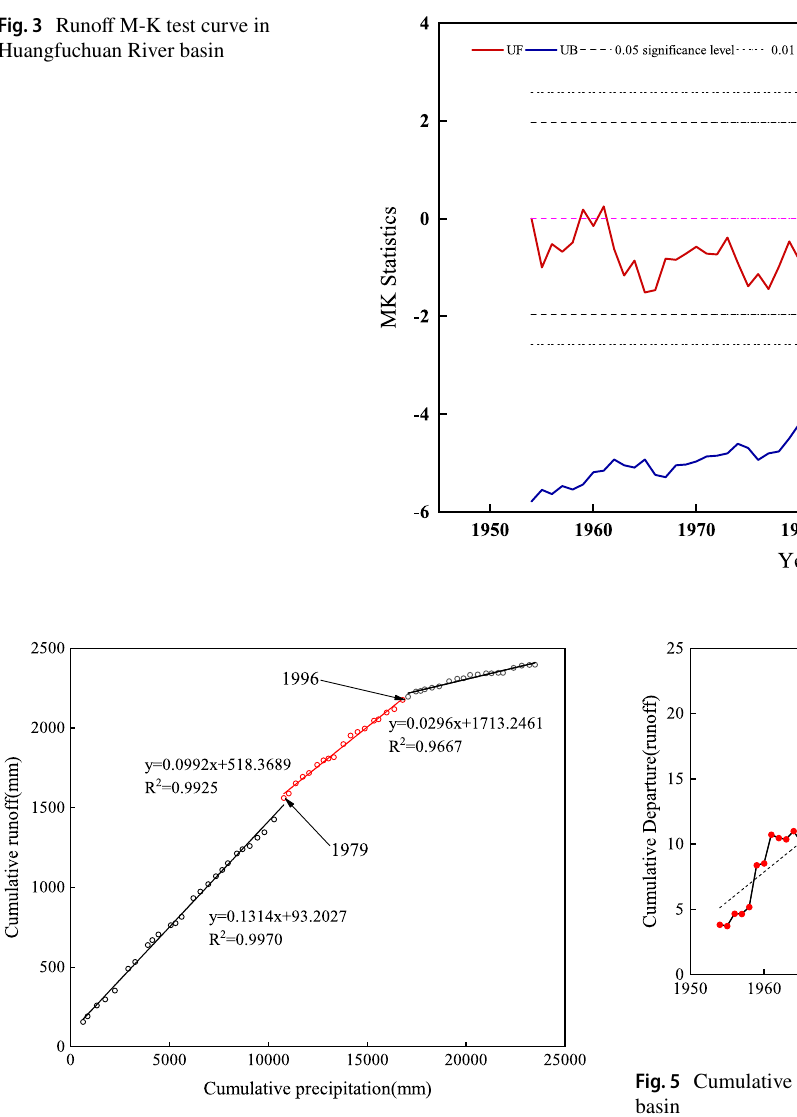
Fig. 4 Double-mass curve of runoff-precipitation in Huangfuchuan River basin